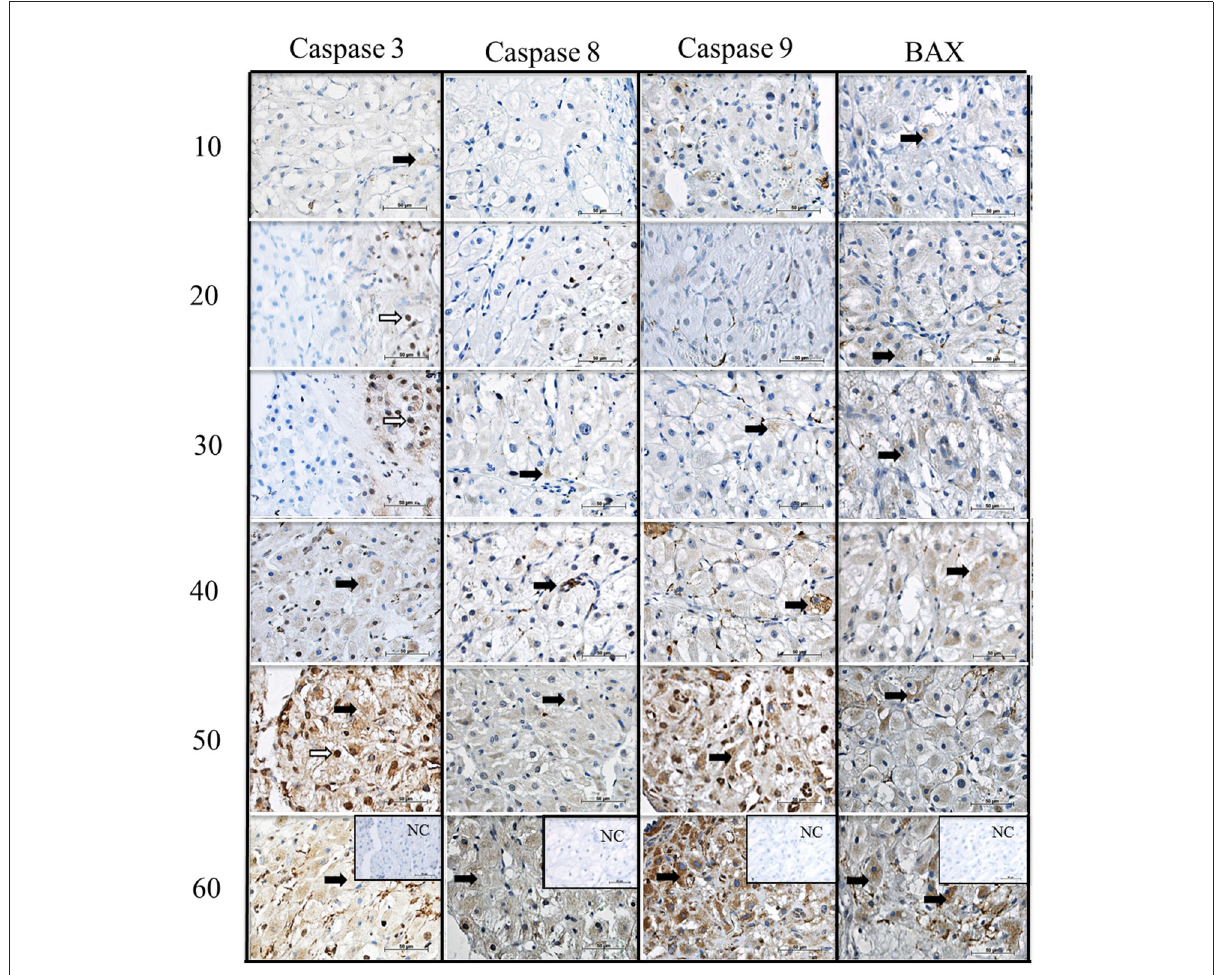
FIGURE4 Immunolocalization of CASPASE 3, CASPASE 8, CASPASE 9 and BAX in canine CL during diestrus. Lines 10, 20, 30, 40, 50, 60, days after ovulation. NC, negative control. Black arrows indicate the cytoplasmic and white arrows indicate nuclear staining. Scale bar 50 µ m.